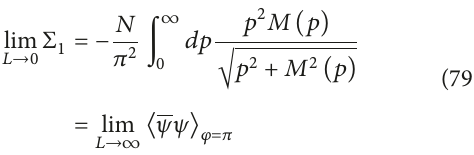
gluons is included or not. The slower UV decrease of the